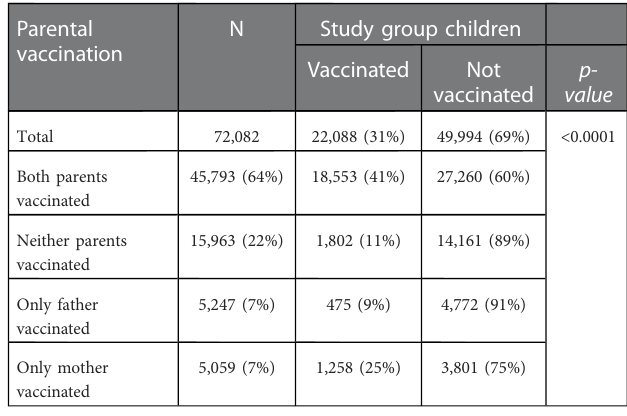
TABLE 4 Parental vaccination